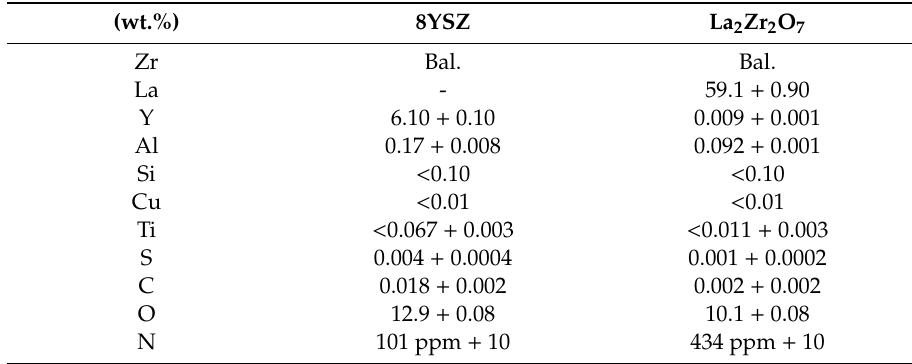
Table 1. Chemical composition of the feedstock